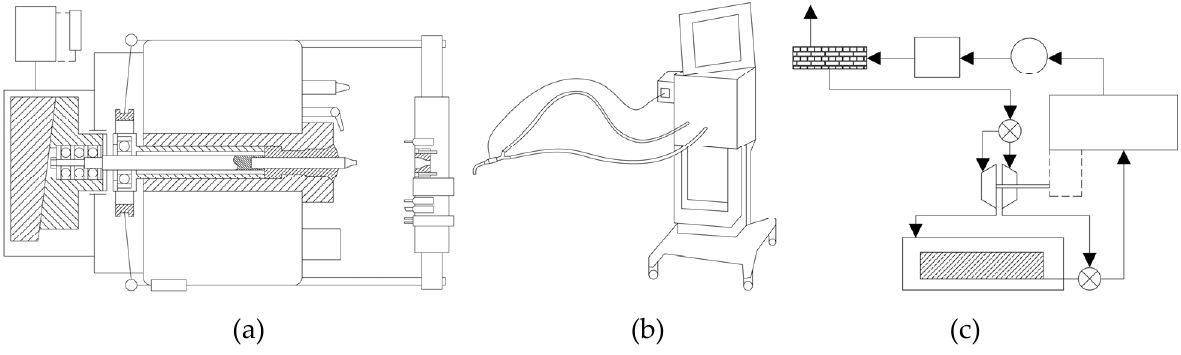
Figure 14. Analogues sources of potential technologies: ( a ) Steel pipe outer taper-processing equip- ment; ( b ) ventilator; ( c ) cryogenic fuel system for aircraft.